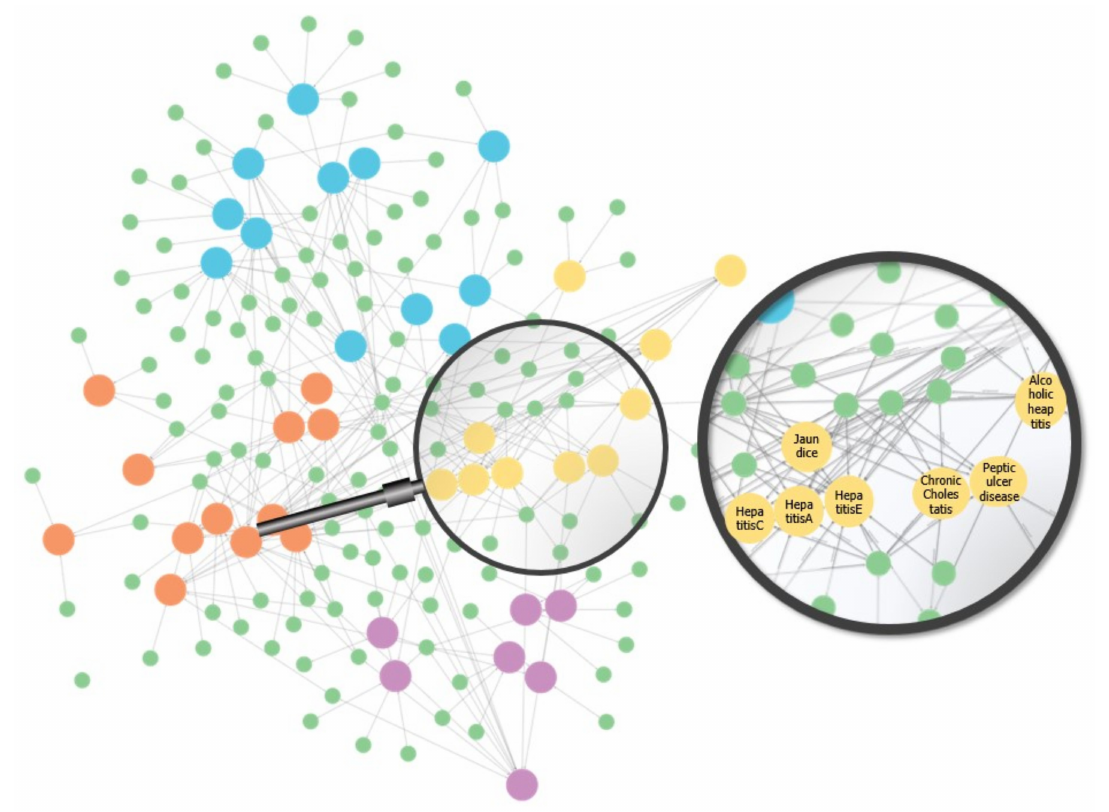
Figure 4. The detected communities on the knowledge graph (to be uploaded).